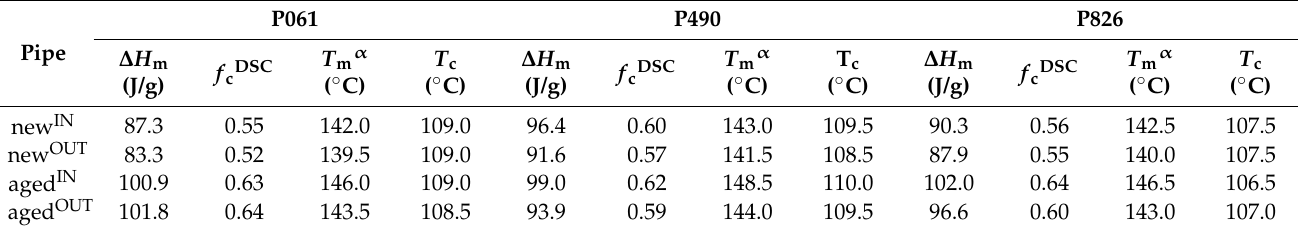
Table 2. Values of melting enthalpy ( ∆ H m ), crystallinity (f cDSC ) and peak temperature (T m α ), estimated from the first heating run, together with the crystallization temperature (T c ) attained from the cooling process (both performed at a rate of 20 ◦ C/min) for the inner and outer parts of either new or aged